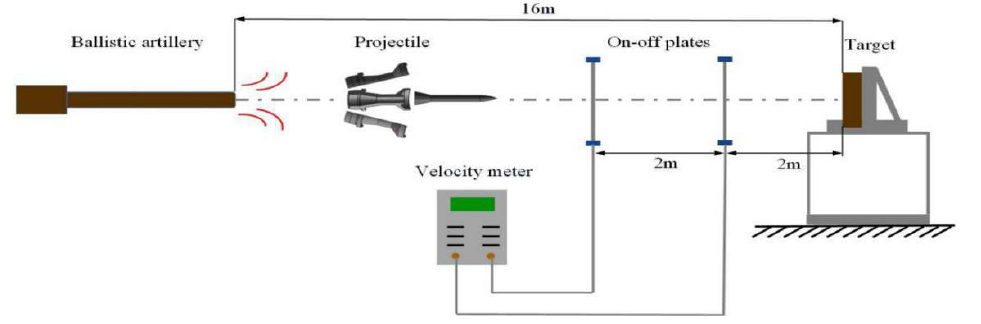
Figure 1. Experimental set-up.